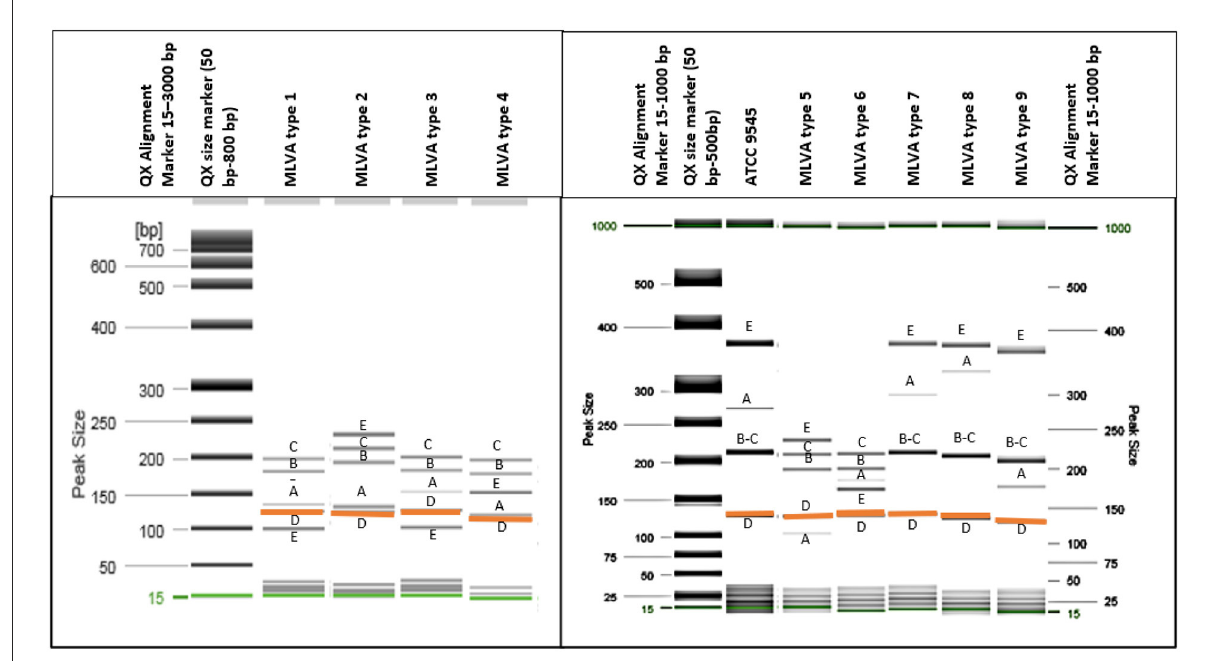
FIGURE1 Nine different MLVA types of P. larvae isolates were identified using QIAxcel capillary electrophoresis (gel image) method. All isolates had a band of around 125 bp length [orange color (D) ], and all five loci were amplified. (A–E) Indicate each VNTR locus. Two bands which differ in very small bp number and are not separated clearly [loci (B,C) ] have more intense dark color.